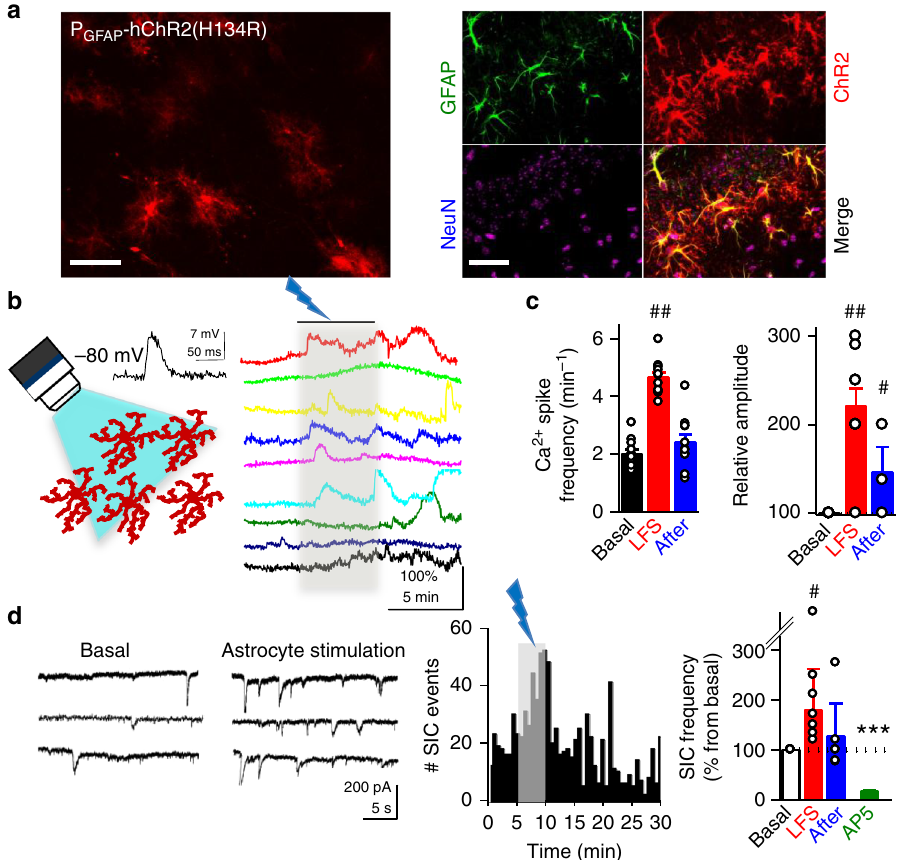
Fig. 3 Optogenetic stimulation of astrocytes induces astrocyte – neuron communication. a (Left) Confocal image of a hippocampal section showing the expression of ChR2-mCherry in astrocytes. (Right) Confocal image of hippocampal organotypic slices immunohistochemically labeled with the astrocytic marker GFAP (green) and the neuronal marker NeuN (cyan). ChR2-mCherry expression is shown in red. Merged image at the lower right corner. Note the selective expression of ChR2-mCherry in GFAP-positive cells (astrocytes). Scale bars, 50 µ m (left) and 40 µ m (right). b (Left) Schematic representation depicting the optical stimulation of ChR2-mCherry-expressing astrocytes, and representative recording of astrocyte membrane potential during optogenetic stimulation (inset) in organotypic hippocampal slices. (Right) Astrocyte Ca 2 + signals evoked by ChR2 stimulation (1 Hz, 5 min; gray bar). c Quanti fi cation of the frequency and relative amplitude of astrocyte Ca 2 + signals before (basal, black bars), during LFS (red bars) and 5 min after (recovery, blue bars) ( n = 69 astrocytes from 9 organotypic slices). Data were compared by Friedman test followed by Dunn ’ s test ( ## P < 0.01). d (Left) Representative example of whole-cell currents from CA1 pyramidal neurons before and during LFS by optogenetic astrocyte stimulation in organotypic hippocampal slices. (Middle) Number of SICs versus time before, during and after optogenetically driven LFS. (Right) Summary of results from experiments as the one shown on the left. Friedman test followed by Dunn´s multiple comparison ( # P < 0.05). AP5 vs. baseline were compared by Mann Whitney